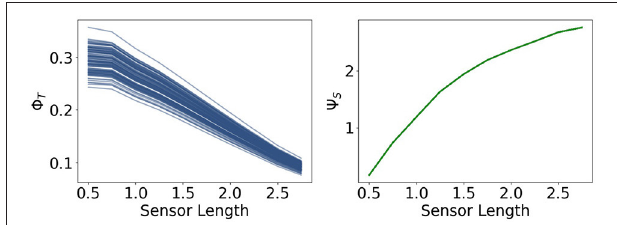
FIGURE 12 | The measures for control 9 C , sensory information 9 SI , action effect 9 A for the controller driven agents and the performance difference the fully coupled agents and the reactive ones.